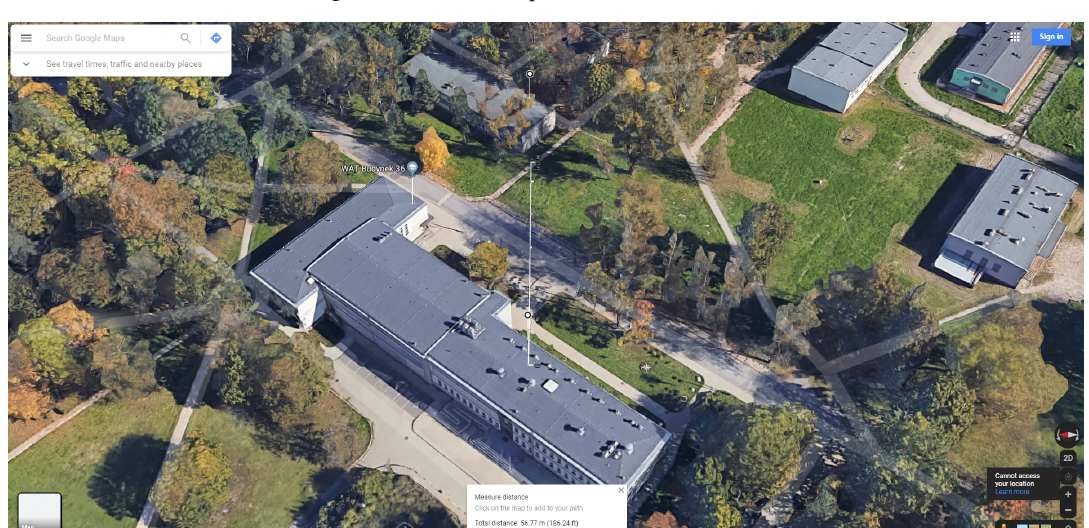
Figure 17. Panoramic picture of the Test Area 1.